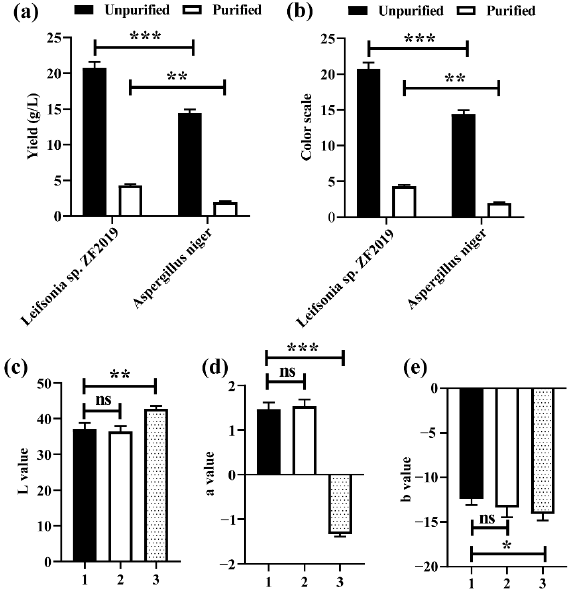
Figure 3. The color scale ( a ) and yield ( b ) of Leifsonia sp. ZF2019 and Aspergillus niger differed sig- nificantly before and after purification. Three GBPs from distinct sources differed in terms of lab color model, including L ( c ), a ( d ), and b ( e ) values. In the figure, 1 represents the GBP prepared by Leifsonia sp. ZF2019 fermentation, 2 is the GBP fermented by Aspergillus niger , and 3 represents the GBP obtained by the reaction of genipin ( ≥ 98%) with Leu. The asterisk represents a significant dif- ference between the groups. *, p < 0.05; **, p < 0.01; ***, p < 0.001; ns, not significant. To evaluate the quality of the GBP, the hue of purified GBP produced by fermenta- tion of Leifsonia sp. ZF2019 and Aspergillus niger were measured using a colorimeter, and the GBP that was directly produced by genipin and Leu was used as the control. As shown in Figure 3c–e, there was no significant difference in the color intensity (L, a, and b values) between GBP produced by Leifsonia sp. ZF2019 and that produced by Aspergillus niger . that of produced by genipin and Leu. The results reveal the excellent GBP production capability of Leifsonia sp. ZF2019. Due to the high level of impurities in the fermentation broth, the color value and hue of the GBP produced by fermentation are low. GBP is usu- ally directly synthesized from the pure geniposide or genipin. Herein, the color of GBP produced by Leifsonia sp. ZF2019 and Aspergillus niger was comparable to the product synthesized from pure genipin. Therefore, fermentation may be used as an alternative method for GBP production. 3.6. Effects of pH, Temperature, and Light on GBP Physical Stability The blue pigment formed by pure genipin was reported to be stable for treatment at temperatures of 60–90 °C for as long as 10 h and under light irradiance of 5000–20,000 lux. It was more stable under alkaline than neutral and acidic conditions [6]. However, the components of GBP produced by the waste of GYWP are more complex than synthetic products. Whether trace amounts of iridoid compounds other than genipin, crocitin, and flavonoids can change the physicochemical stability of GBP remained to be clarified. Therefore, the influence of pH, heat, light, oxidant or reluctant, some common food addi- tives, and metal ions on GBP stability was re-evaluated.